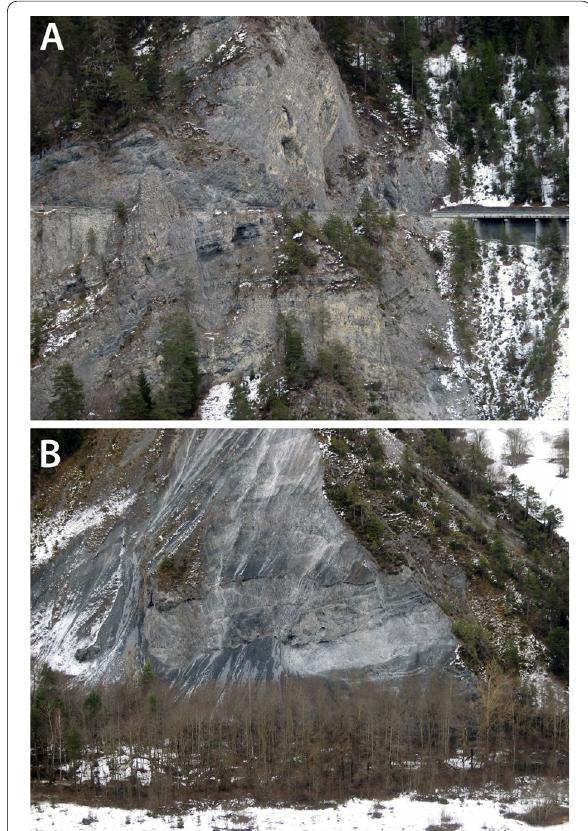
Fig. 22 Large compartments in the outcrops in the flank above Isla Davos. A Bedding in a tilted block. Bedding gets steeper as one goes into the flank. B An isolated block with visible stratification is floating in comminuted limestone. Photos A.